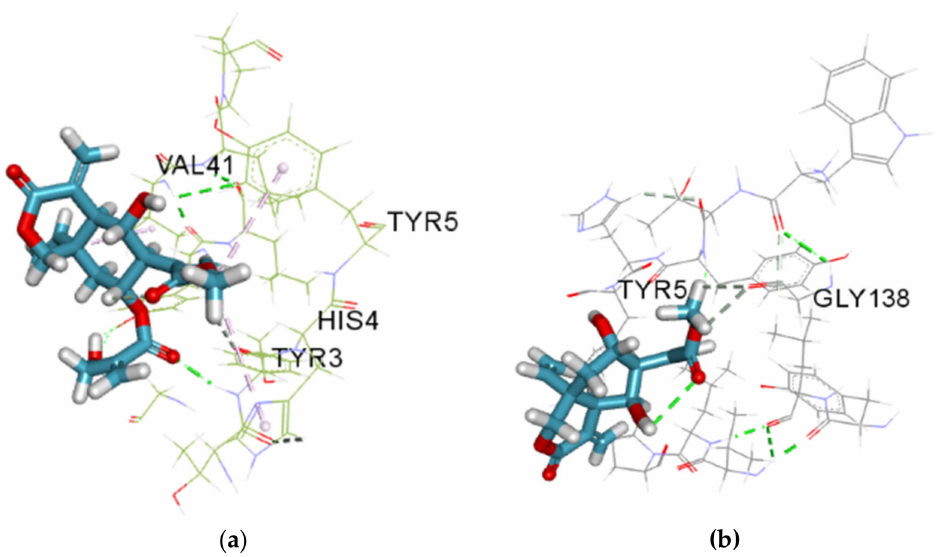
Figure 7. ( a ) Vernodalol in the active site of P-Selectin (PDB ID: 1G1S). Predicted hydrogen bonding interactions can be seen between vernodalol and active residues VAL 41, TYR5, TYR3 and HIS4. ( b ) Interaction between lasiopulide and P-selectin (PDB ID: 1G1S). Conventional Hydrogen bond (solid green colour), carbon-hydrogen bond (solid grey colour) and Pi-Alkyl (solid lilac colour).